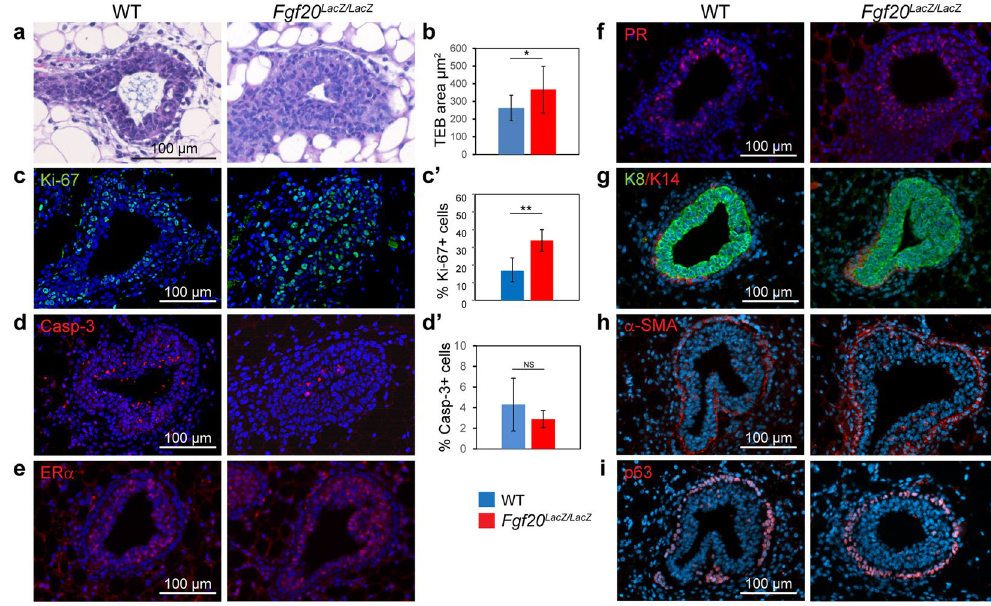
Figure 7. Analysis of terminal end buds of Fgf20 LacZ/LacZ mice at 7 weeks of age. ( a ) Hematoxylin Eosin -stained sections of WT and Fgf20 LacZ/LacZ TEBs. ( b ) Quantification of TEB area from Carmine alum stained mammary glands of WT (n = 9) and Fgf20 LacZ/LacZ (n = 12) mice. ( c , c’ ) Immunohistochemical staining and quantification of Ki-67 –positive cells in TEBs of WT (n = 4) and Fgf20 LacZ/LacZ (n = 5) mice. Total number of TEBs analyzed was n = 26 (WT), n = 30 ( Fgf20 LacZ/LacZ ). ( d , d’ ) Immunohistochemical staining and quantification of cleaved caspase-3 –positive cells in WT (n = 4) and Fgf20 LacZ/LacZ mice (n = 4). Total number of TEBs analyzed was n = 34 (WT), n = 29 ( Fgf20 LacZ/LacZ ). ( e–i ) Immunohistochemical staining of ER α ( e ), PR ( f ), K8 and K14 ( g ), SMA α ( h ), and p63 ( i ) in the TEBs of WT and Fgf20 LacZ/LacZ mice. Minimum of 4 mice per genotype were analyzed. Values represent mean ± SD. ** p < 0.01; * p < 0.05; NS, not